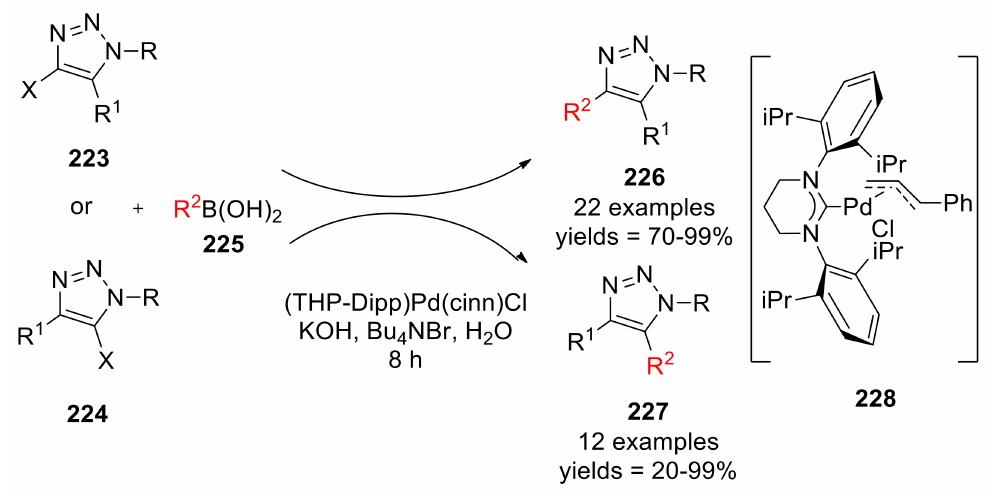
Scheme 72. Suzuki–Miyaura cross-coupling of 4- or 5-halo-1,2,3-triazoles with arylboronic acids. In more recent work, Duan et al. [127] reported a palladium-catalyzed selective three- component tandem reaction of allenynes 229 , aryl or alkenyl iodides 230, and sodium azide for the synthesis of differently substituted bicyclic 1,2,3-triazoles 231 in discrete yields (45– 79%). The employed substrates include mono-substituted-,1,3-disubstituted-, trisubstituted allenynes, and different types of organic iodides. Finally, the authors proposed a plausible reaction mechanism (Scheme